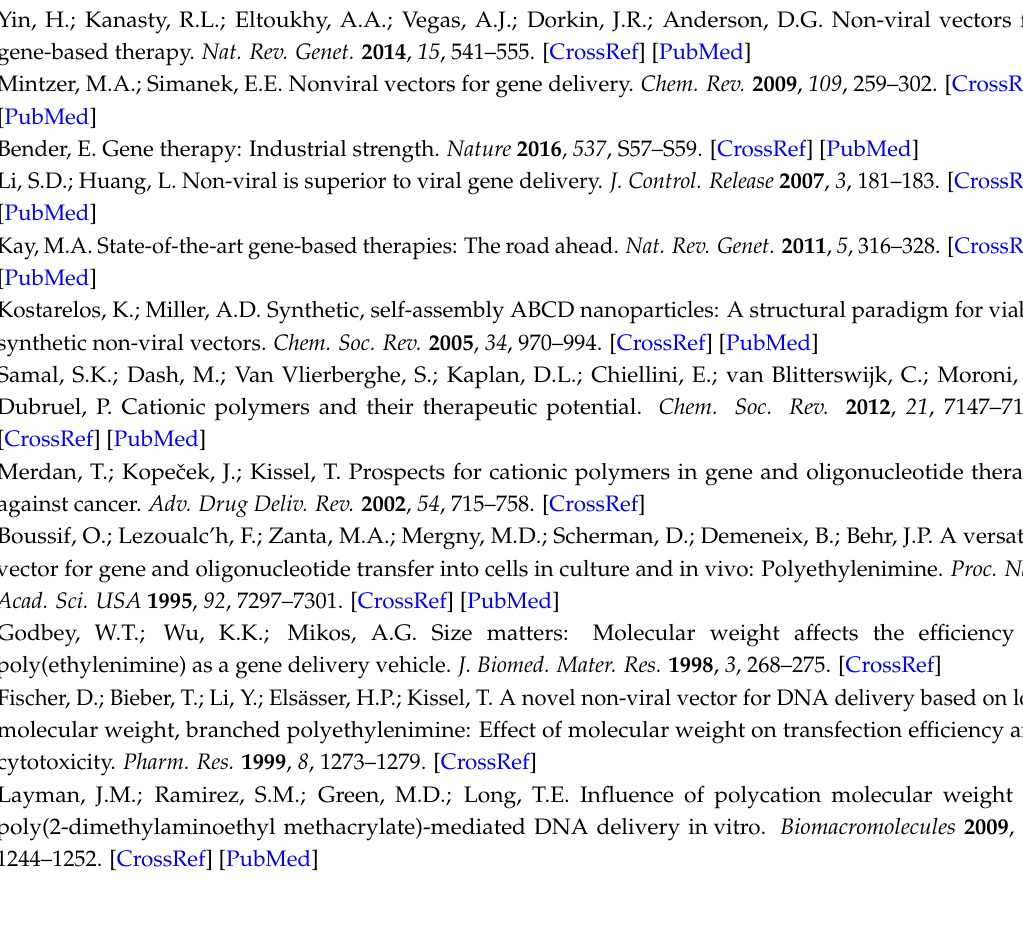
Figure S1: GPC trace of poly(methylaminostyrene), the parent polymer for both PMAS(Bu) and PMAS(iP); Figure S2: Gel electrophoresis shift assay of pDNA polyplexes formed with PMAS(Bu) at the indicated polymer: pDNA weight ratios. All pDNA is bound in polyplexes at a weight ratio of 1.66 PMAS(Bu): 1 pDNA; Figure S3: Gel electrophoresis shift assay of pDNA polyplexes formed with PEI(Bu) at the indicated polymer:pDNA weight ratios. All pDNA is bound in polyplexes at a weight ratio of 3.33 PEI(Bu): 1 pDNA; Figure S4: Gel electrophoresis shift assay of pDNA polyplexes formed with PMAS(iP) at the indicated polymer:pDNA weight ratios. All pDNA is bound in polyplexes at a weight ratio of 1.66 PMAS(iP): 1 pDNA; Figure S5: Gel electrophoresis shift assay of pDNA polyplexes formed with PEI(iP) at the indicated polymer:pDNA weight ratios. All pDNA is bound in polyplexes at a weight ratio of 0.83 PEI(iP): 1 pDNA; Table S1: Polymer loading and pDNA weight ratios for gel electrophoresis and transfection experiments; Table S2: Conversion of weight ratios to charge ratios for each tested